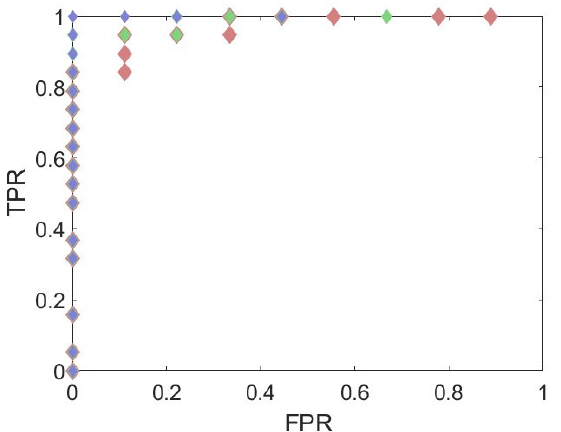
Figure 13. Three different Go, No ‐ Go ROC curves for the Y ‐ axis and Z ‐ axis PSD thresholds. The blue markers display a combination with the prediction results 100% TPR and 0% FNR. This plot was built using the same data as Figure 12.